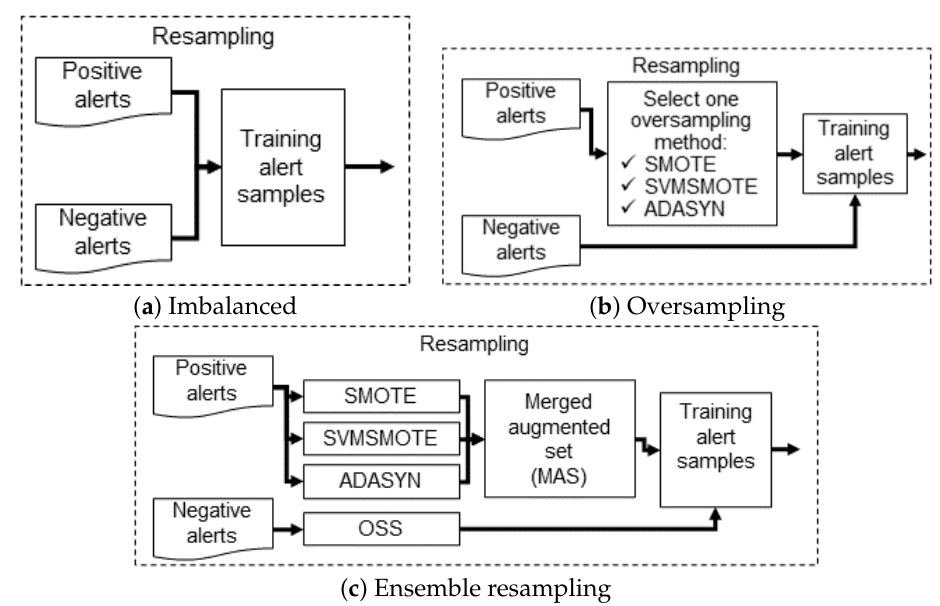
Figure 2. Security alert training samples